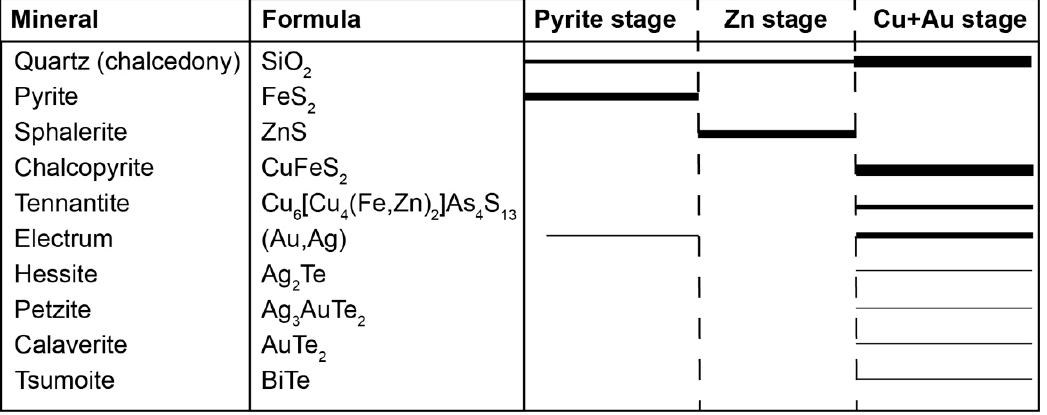
Figure 10. Paragenetic sequence deduced for the mineralization in the Romero deposit. The width of the bars approximates the relative abundance of the listed minerals. Quartz (chalcedony) refers only to the occurrence of this mineral within the stockwork veins (lower zone). Hydrothermal alteration phases are not included in the table.